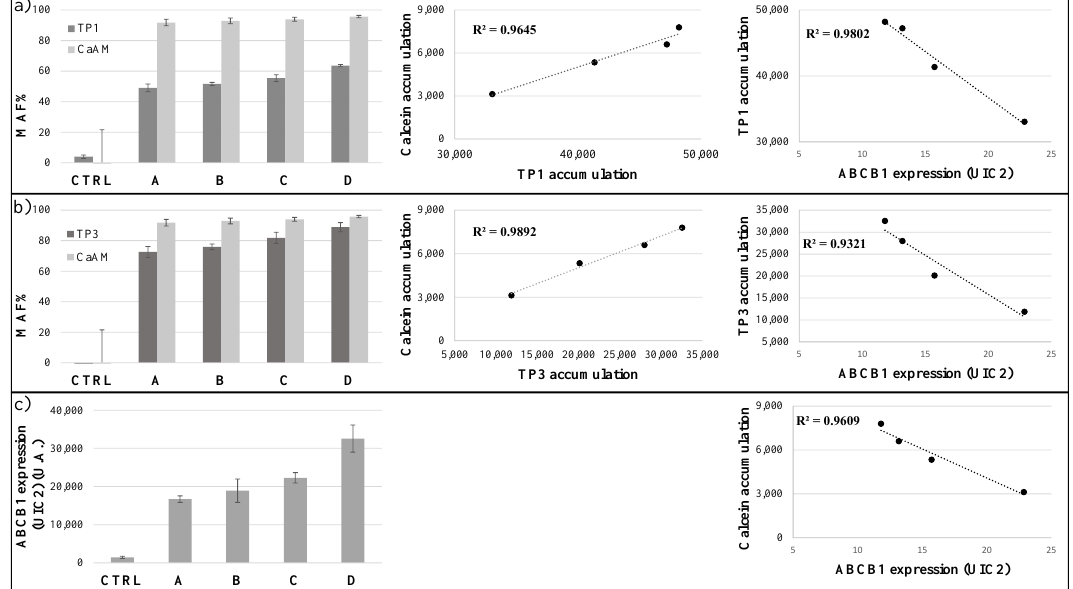
Figure 4. TP sensitivity assay in the MES-SA cell line. Uptake of 500 nM TP1 (( a ), dark gray) or 100 nM TP3 (( b ), dark gray) in the control and different ABCB1-expressing MES-SA cells was measured after 24 h incubation at 37 ◦ C. Calcein accumulation (( a , b ), light gray) was measured in control and ABCB1 expressing MES-SA cells after the addition of 250 nM Calcein-AM. MAF values were calculated as described in Methods. In all cases, Tariquidar (TQ, 250 nM) was applied as the selective inhibitor of ABCB1. Determination of cell surface expression of ABCB1 was performed by UIC2 antibody labeling ( c ). ABCB1 expressions were estimated relative to that in the CTRL cells. A scatter plot shows the relationship between the accumulation of TP1 or TP3 and the accumulation of Calcein, or the membrane expression levels of ABCB1. The scatter plots and the corresponding regression lines and linear regression coefficients (R 2 ) were calculated by Excel (+/- SD values are indicated, n = 3). Interestingly, the MAF values obtained by measuring Calcein accumulation were less sensitive to the actual expression levels, probably because even low ABCB1 expression levels caused a maximum inhibition of Calcein AM uptake. The best correlation with the low levels of ABCB1 in the MES-SA cell membranes, measured by specific monoclonal antibody binding, was shown by the TP1 uptake (R 2 = 0.9802). TP3 accumulation was somewhat less sensitive to the low levels of ABCB1 expression, giving high MAF values even at low membrane ABCB1 levels (R 2 = 0.9321). Calcein accumulation was similar to TP3 accumulation (R 2 = 0.9609). The relationship between the accumulation of the cyanine dyes and the accumulation of Calcein was strong, although TP1 accumulation was more sensitive, shown by the respective MAF values (TP3/Calcein R 2 = 0.9892, TP1/Calcein R 2 =